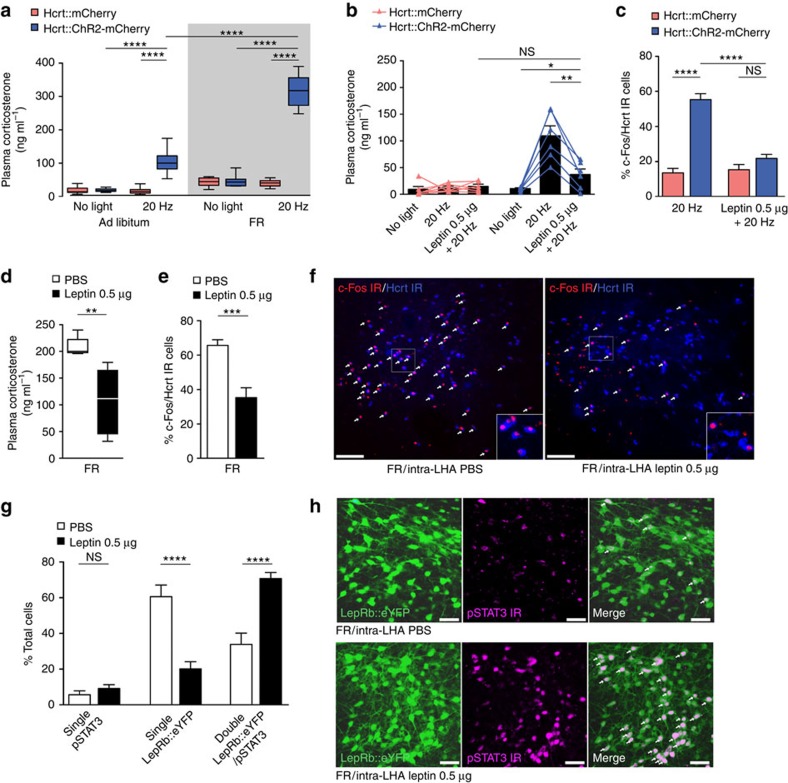
Leptin modulates Hcrt-evoked increase in plasma corticosterone.(a) Hcrt photostimulation (20 Hz, 1 h, 10 s IPI) following 7 days of food restriction (FR) enhances corticosterone increase in ChR2 mice (blue, n=10) compared with their stimulated fed state (ad libitum) or controls (red, n=10). ****P<0.0001. (b) LHA local injection of leptin (0.5 μg) suppresses Hcrt-evoked corticosterone increase in stimulated ChR2 mice (blue, n=6) compared with controls (red, n=6). *P<0.05, **P<0.01. Triangles represent corticosterone concentrations for individual mice. (c) Leptin inhibits c-Fos IR in stimulated Hcrt::ChR2 neurons (PBS: n=5, Hcrt::ChR2–mCherry/Hcrt::mCherry mice; leptin: n=6, Hcrt::ChR2–mCherry/Hcrt::mCherry mice). ****P<0.0001 (d) Wild-type mice receiving chronic bilateral injection of leptin (0.5 μg; black, n=5 FR) in the LHA showed reduced corticosterone concentrations following FR compared with PBS-treated mice (white, n=5 FR). **P<0.01. (e) LHA leptin injections suppress FR-induced c-Fos IR in Hcrt neurons (***P=0.001). Bar graphs quantify the percentage of double c-Fos/Hcrt IR neurons (leptin: black, n=5 FR; PBS: white, n=5 FR). (f) Representative photomicrographs of LHA sections co-stained for c-Fos (red) and Hcrt neurons (blue) from leptin and PBS-treated FR mice. White arrows identify double c-Fos/Hcrt IR neurons. Scale bar, 100 μm. (g) Bar graphs represent the percentage of pSTAT3-positive neurons and co-stained pSTAT3/LepRb–eYFP neurons in response to leptin and PBS treatment in FR mice (****P<0.0001). (h) Representative photomicrographs of LHA sections stained for pSTAT3 from PBS and leptin-treated LepRb–eYFP mice following chronic FR. White arrows identify LepRb–eYFP neurons (green) expressing pSTAT3 (magenta). Scale bar, 50 μm. ‡Two-way repeated measures ANOVA between viral transduction and feeding state conditions, or pharmacological conditions, or between pharmacological conditions and fed state. §One-way repeated measures ANOVA followed by Tukey’s post-hoc test. NS, not significant (P≥0.05), *P<0.05, **P<0.01, ***P<0.001, ****P<0.0001 two-tailed Student’s t-test. Bars in b–g represent mean±s.e.m. In a, centre lines show the median, boxes extend from 25th to 75th percentiles, whiskers indicate minimum and maximum values.